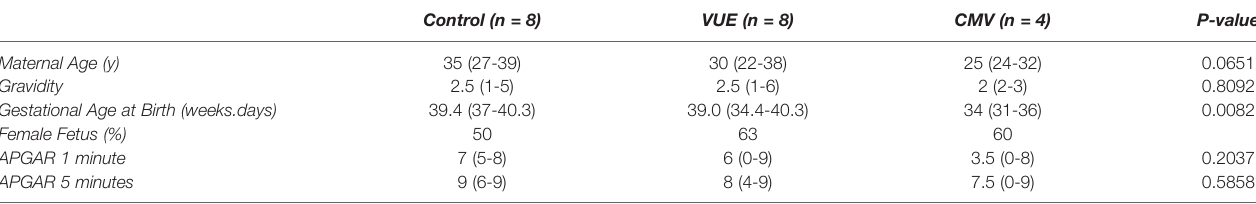
Data presented as medians with